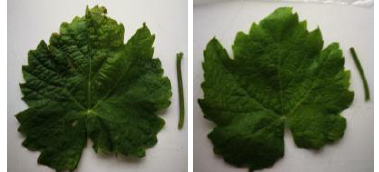
Figure 1. Vinhão FD negative leaf (left) and Vinhão FD positive leaf (right)